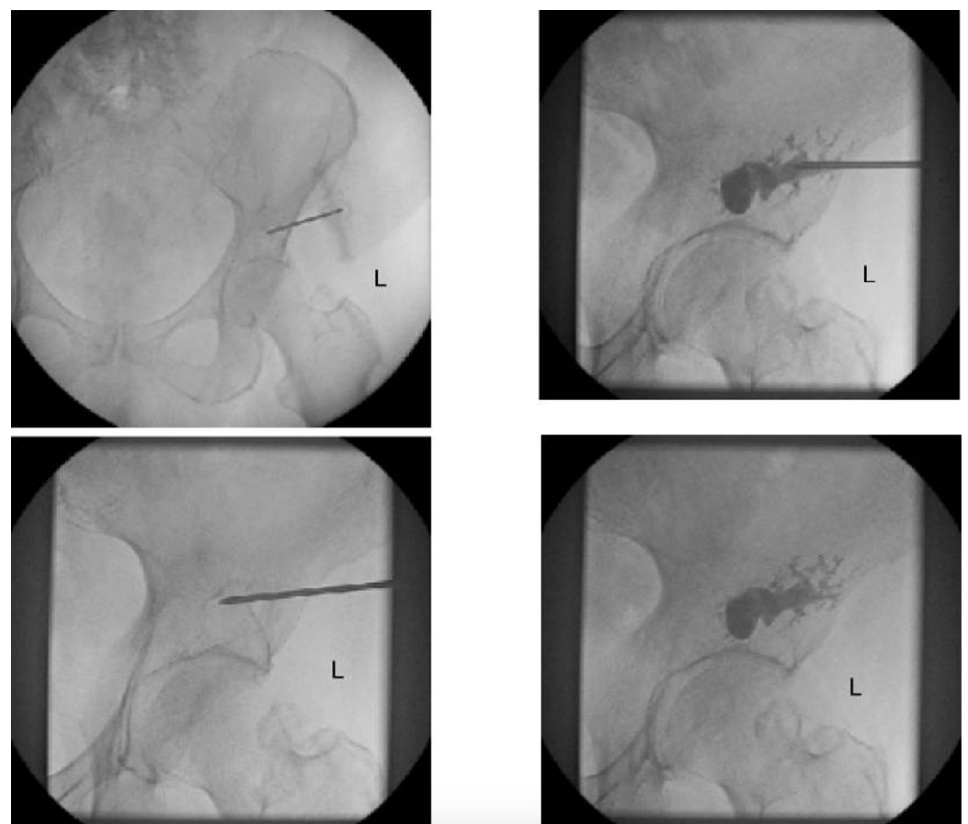
Figure 2. Intraoperative fluoroscopy demonstrating percutaneous cementoplasty of a lytic metastatic lesion in the left acetabulum, courtesy of Harris et al. [18].